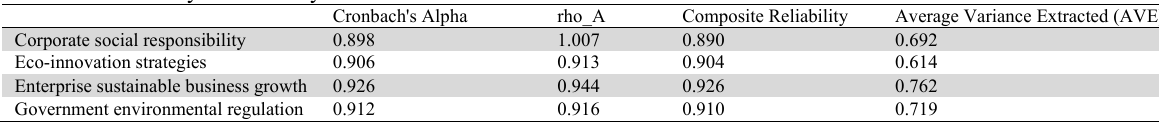
Construct Reliability and